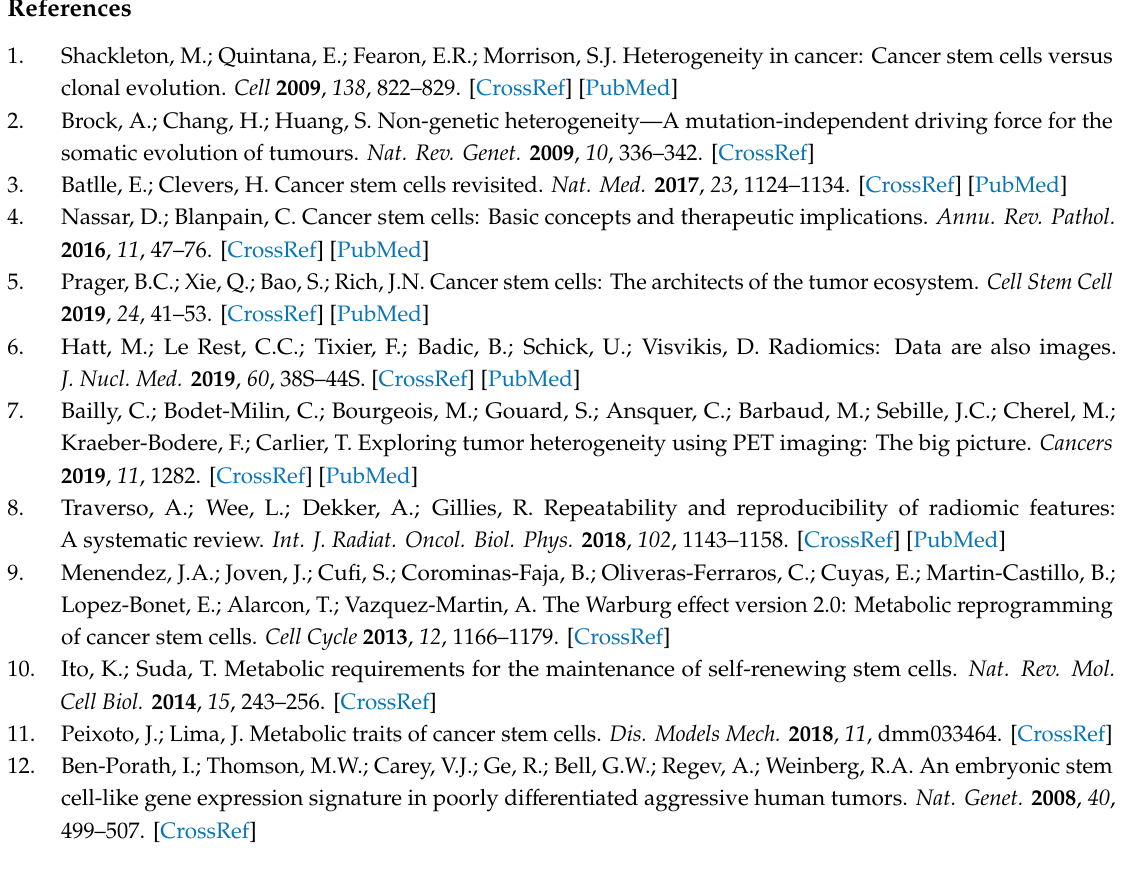
Table S1: MTVcsc measurement in target lesions, Table S2: Prediction of tumor response to NAC using MTVcsc according to the molecular